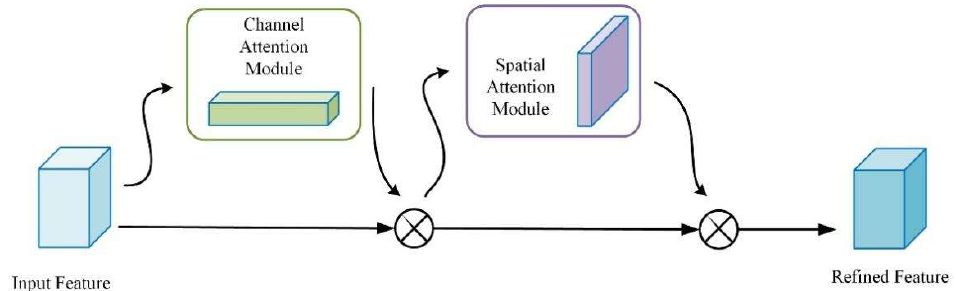
Figure 5. CBAM module structure schematic.